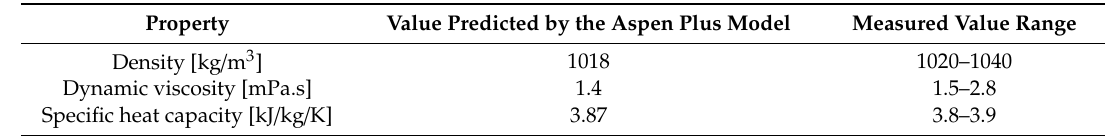
Table 2. Comparison of measured milk properties [17,32,33] with properties predicted by the Aspen Plus model for fresh pasteurized whole milk at 15 ◦